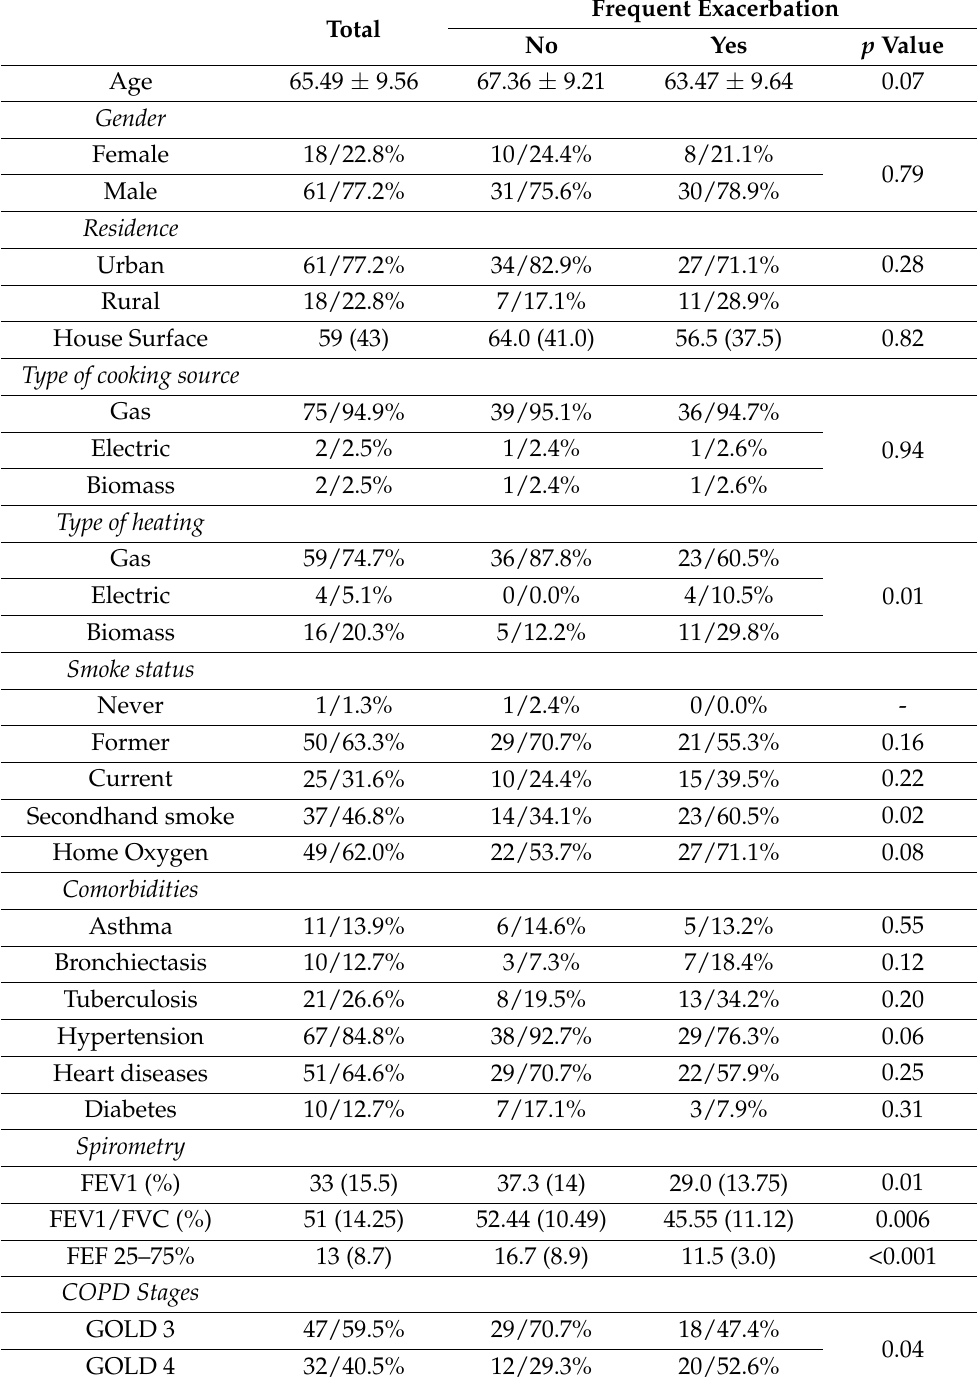
COPD = Chronic obstructive pulmonary disease; FEV1 = Forced expiratory volume in the first second; FVC = Forced vital capacity; FEF25–75% = forced expiratory flow at 25–75% of the pulmonary volume; GOLD = The Global Initiative for Chronic Obstructive Lung